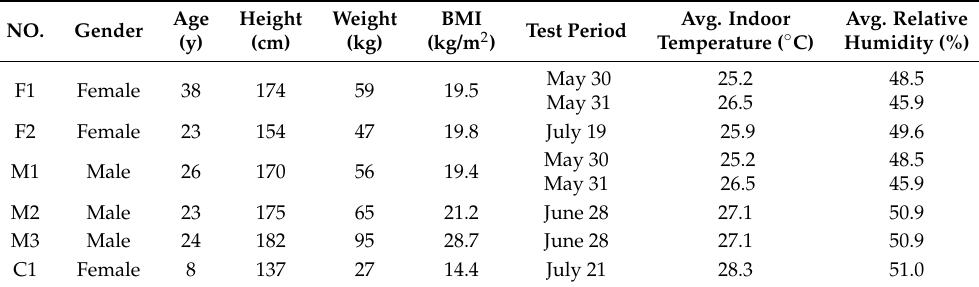
Table 3. All participants had no physical defects, lack of sleep, depression, and other conditions. Table 3. Brief information on